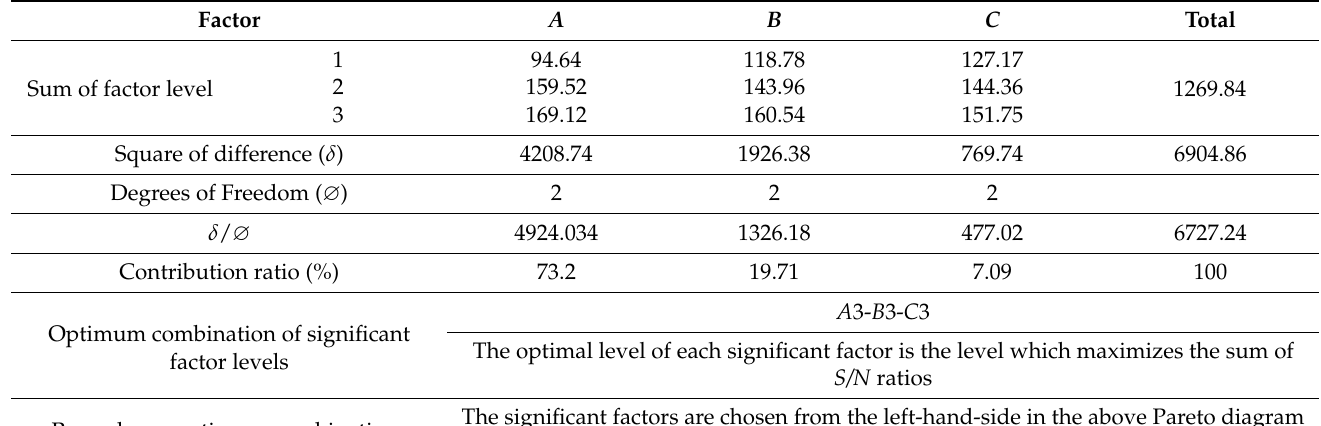
Table 11. Calculation of the contribution ratio of electropolishing machining